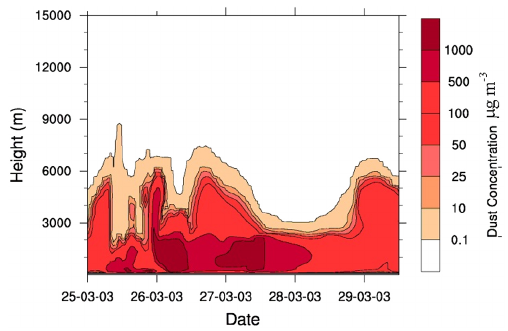
Fig. 12. The SKIRON atmospheric modeling of the dust’s aerial, integrated vertical profile for the period of 25–29 March 2003. Two pockets of high dust concentration are generated around 26– 27